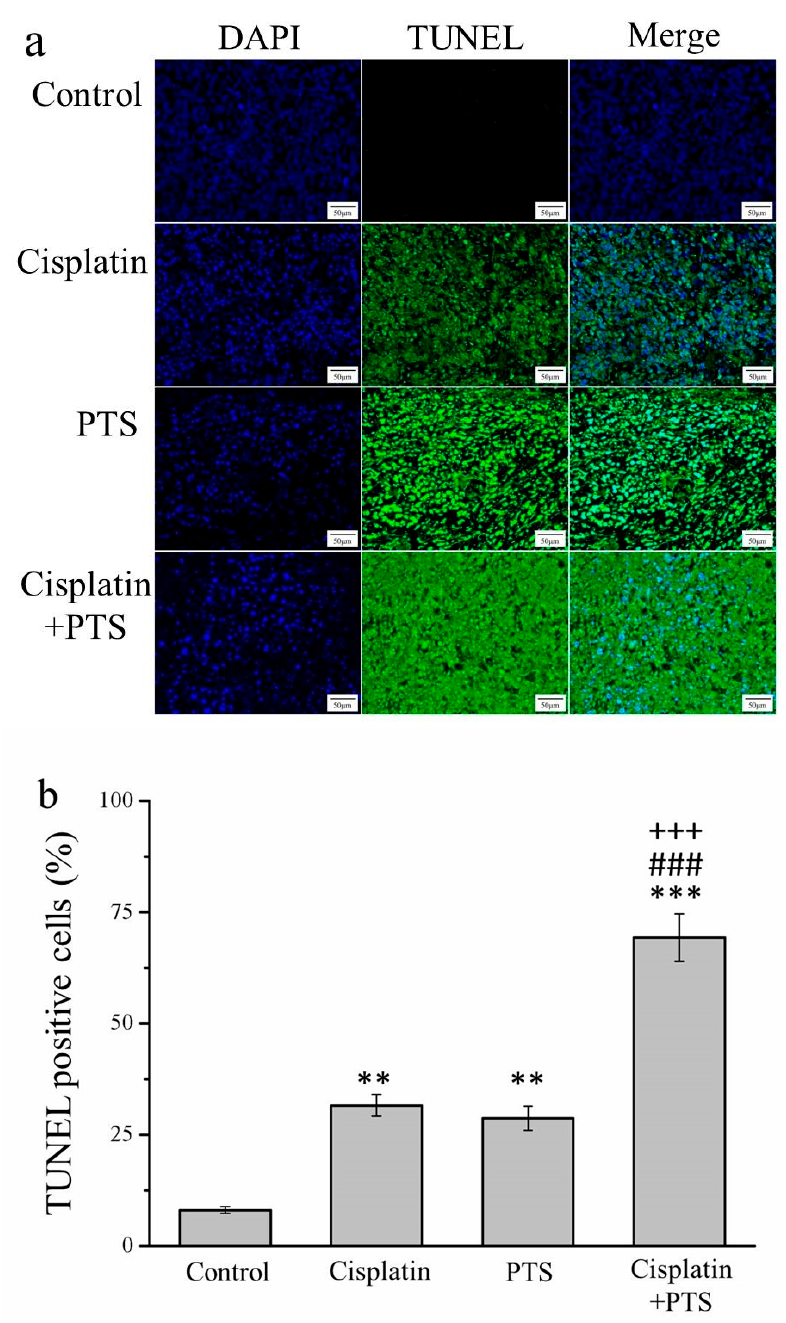
Figure 2. TUNEL/DAPI assay of apoptosis in M5 canine melanoma tumors implanted in BALB/c nude mice. ( a ) Staining with DAPI, TUNEL, and their merging. ( b ) Percentage of cells in the tumors that were TUNEL-positive in control mice and those administered with one of the following treatments three times per week, starting on day 7 (when the tumors were detected): saline (control), 2 mg/kg cisplatin (cisplatin), 100 mg/kg PTS (PTS), or 100 mg/kg PTS and 2 mg/kg cisplatin (cisplatin + PTS). Data are presented as mean ± SD, n = 7 per group. ** p < 0.01, *** p < 0.001 vs. control; ### p < 0.001 vs. cisplatin; +++ p < 0.001 vs. PTS. Scale bars: 50 µm; magnification: 200×.